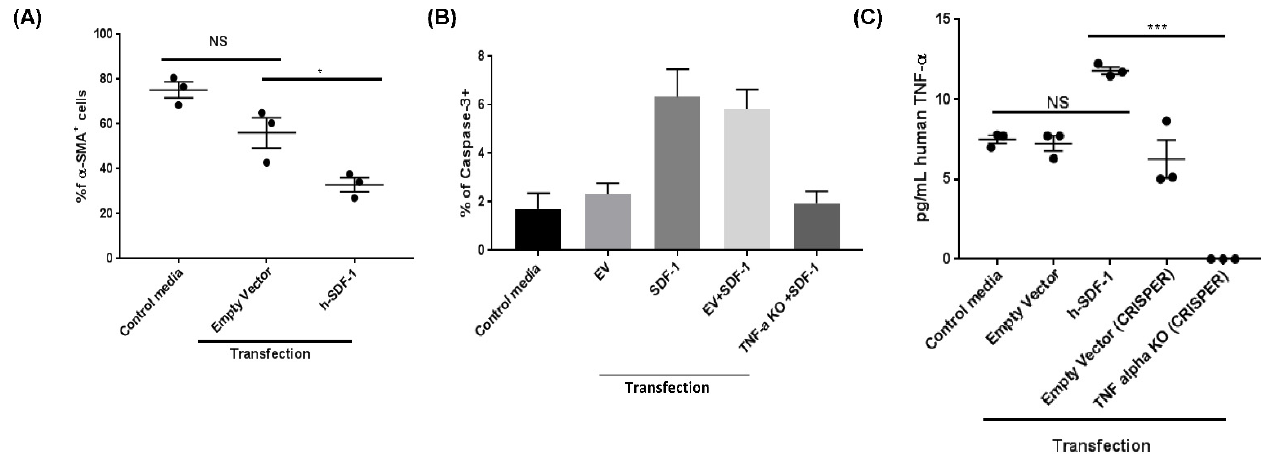
Figure 7. Effects of h-SDF-1 in vitro. Increased apoptosis of IPF lung fibroblasts after pSDF-1 transfection in vitro ( A ), the apoptosis is Caspase 3-mediated ( B ) and TNF- α plays role in induction of apoptosis ( C ). ( n = 3, *: p < 0.05; ***: p < 0.001, NS (not significant)).